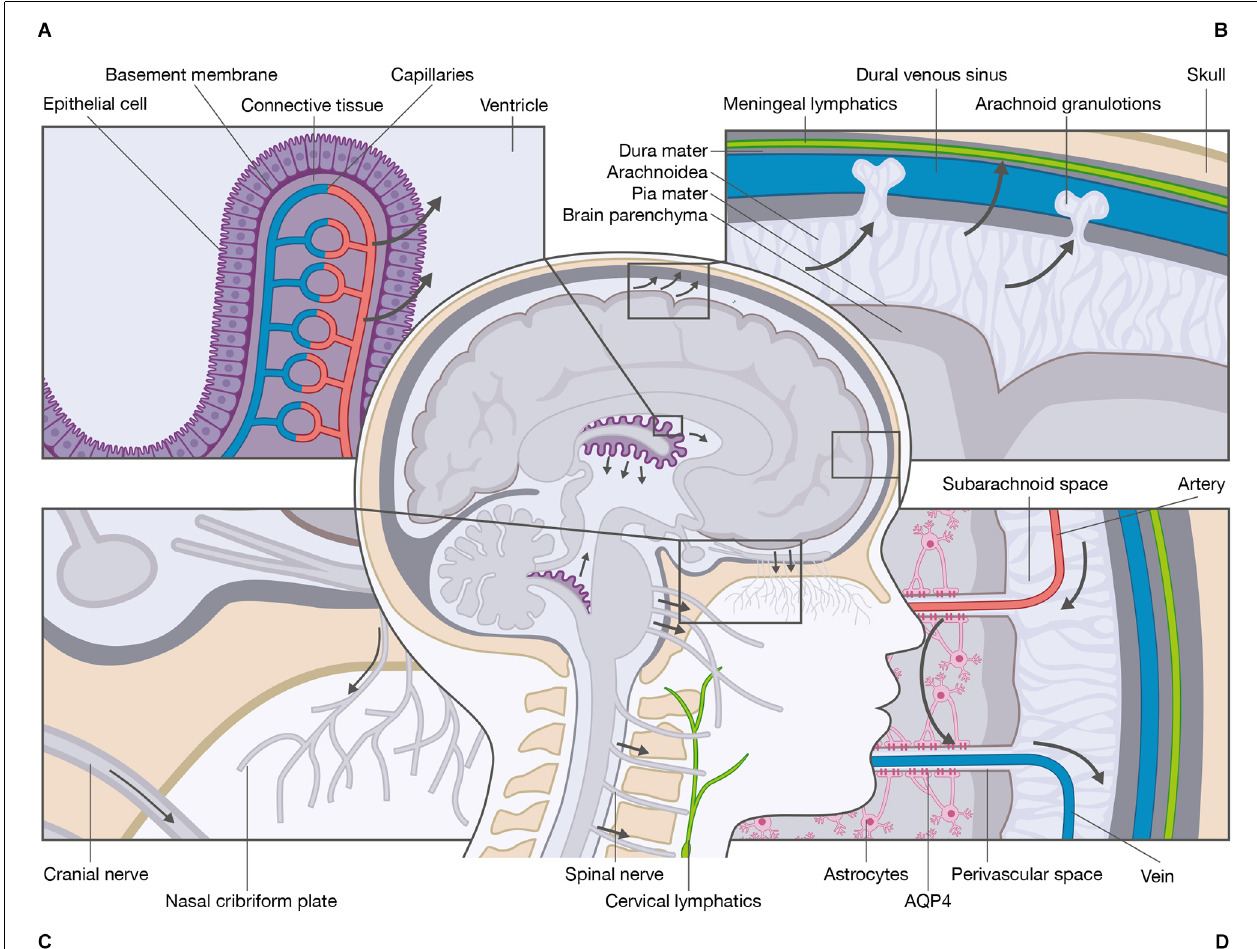
FIGURE 1 | Schematic overview of the cerebrospinal fluid system. The primary site of cerebrospinal fluid (CSF) production is the choroid plexi located within the lateral, third, and fourth ventricles of the brain. (A) The choroid plexi consist of leaky epithelial cells, a basement membrane, connective tissue, and fenestrated capillaries. The CSF production is mediated by ionic transport that generates osmotic gradients and water transport from the blood system to the ventricular system. (B) Several anatomical sites are responsible for CSF absorption e.g., arachnoid granulations, meningeal lymphatics, and (C) cranial nerve sheaths and nasal cribriform plate to the cervical lymphatics. (D) One essential function of CSF is the delivery of nutrients and the removal of waste products. The most recently proposed mechanism for removal of waste is the glymphatic system. The CSF enters from the perivascular spaces surrounding arteries into the brain parenchyma via mechanisms that include AQP4 water channels located at the astrocytic end-feet. Within the brain parenchyma, CSF disperses and intermixes with the interstitial fluid (ISF) and waste products. The mixture of CSF, ISF, and waste products enters the perivascular spaces surrounding veins by unknown mechanisms, e.g., AQP4 water channels. From the perivascular spaces, the mixture leaves the brain